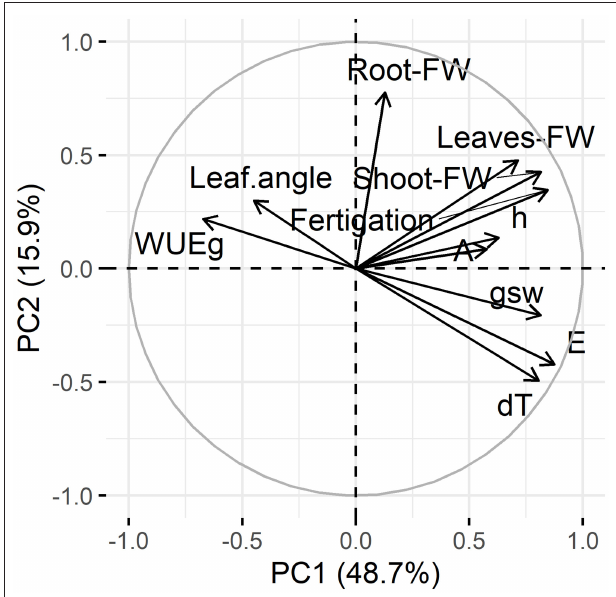
FIGURE 2 | Variable correlation and representation. Projection of input variables on the factor map using PC1 and PC2. Distance from the center of the cycle represents the squared cosine, a measure for variable representation within the first two dimensions. Angle between variable vectors indicates co-correlation. Projected traits are leaf angles, leaf color (h), stomatal conductance (g sw ), transpiration (E), assimilation (A), intrinsic water use efficiency (WUE g ), total fresh weight (FW) of root, shoot and leave, as well as the fertigation and leaf temperature difference